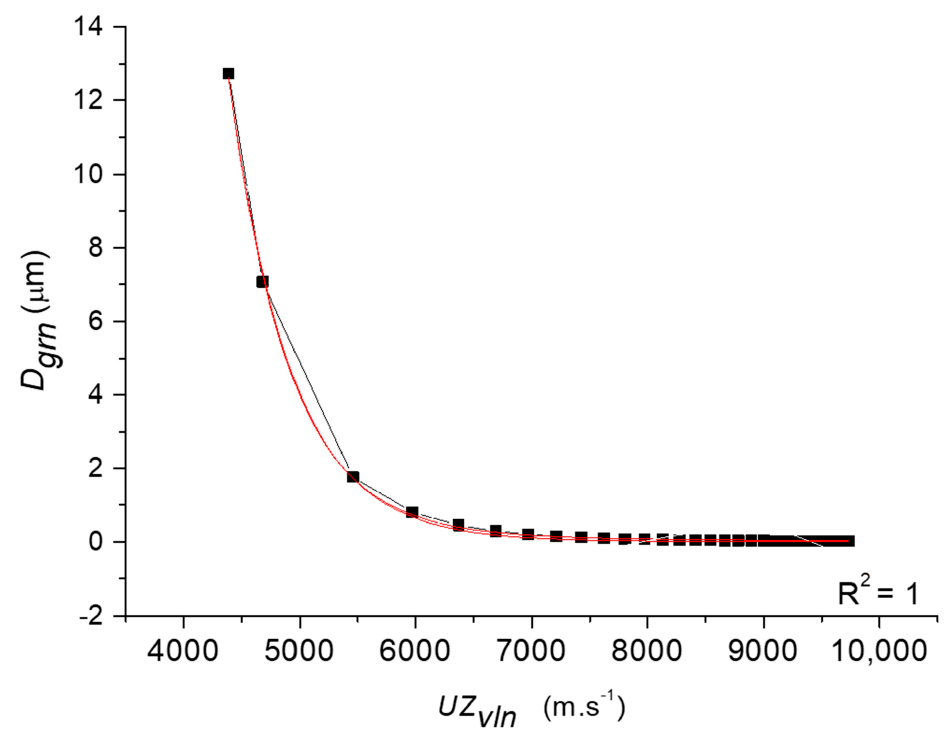
10 Figure 10. Correlation relation D grn = f( UZ vln ), which is given by Equation